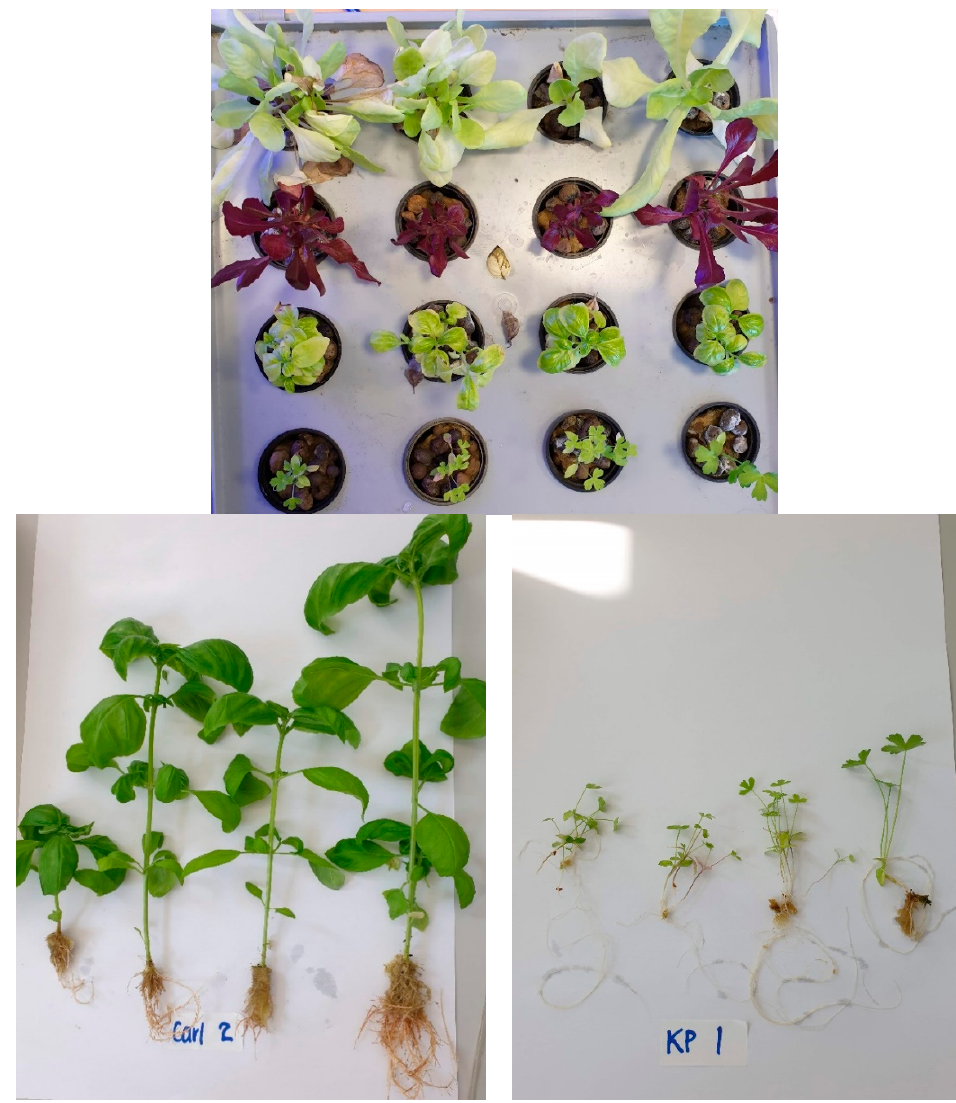
Figure 16. ( Top ): The tray with growth of green lettuce, red lettuce, basil, and parsley after 43 days in a GrowBot. Bottom: Harvest of one row of plants grown in two different GrowBots with each program during the 43 day experiments, including their roots ( left ): basil (from the 2nd row of a GrowBot named Carl), ( right ): parsley (from the 1st row of a GrowBot named KP).